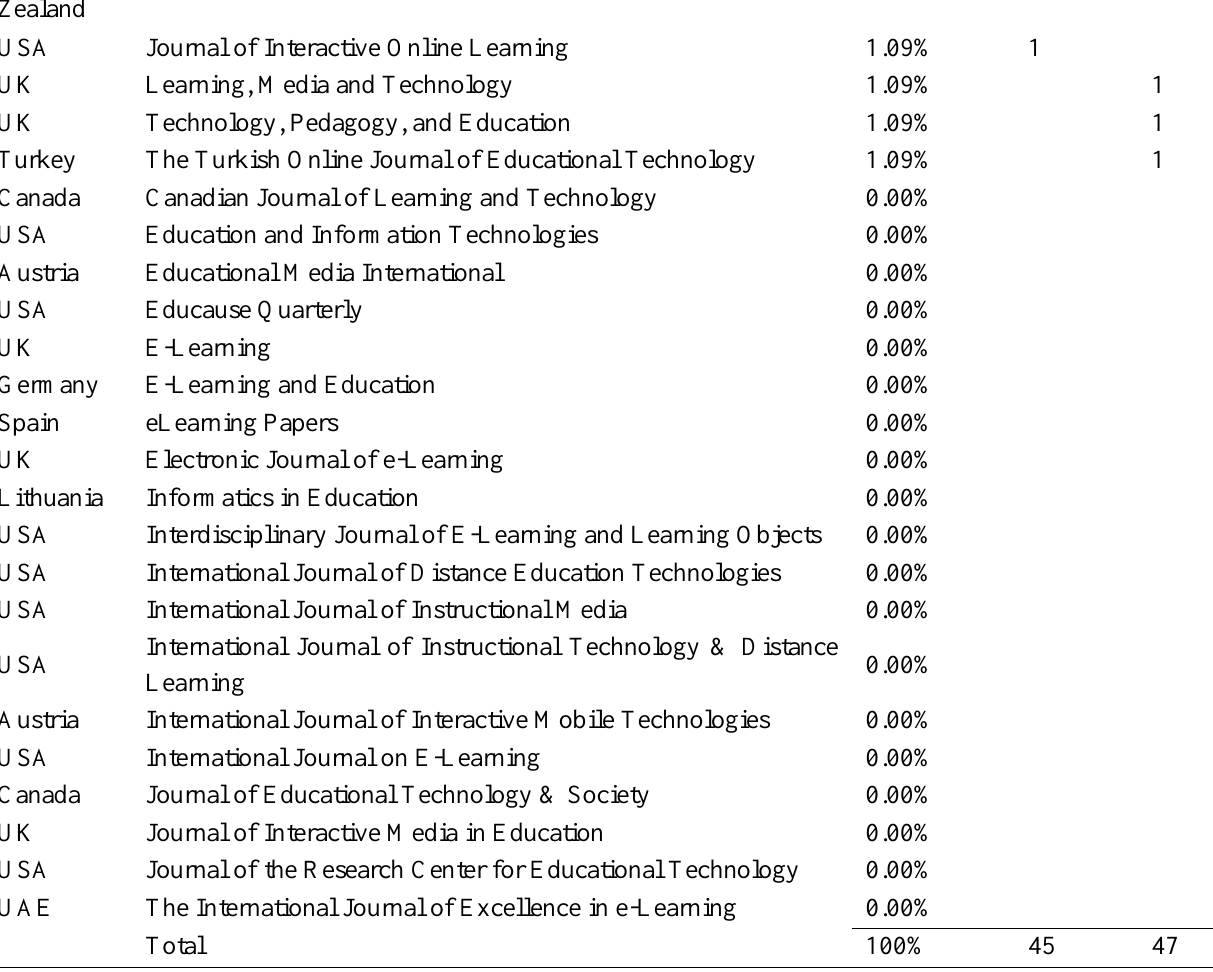
Table 5 presents all three popularity, importance, and prestige rankings as indexes to produce a final overall journal ranking. The indexing was computed as the journal‟s score divided by the highest score for a particular ranking. For example, the prestige index for Distance Education = 7.61/10.87 = 0.70.